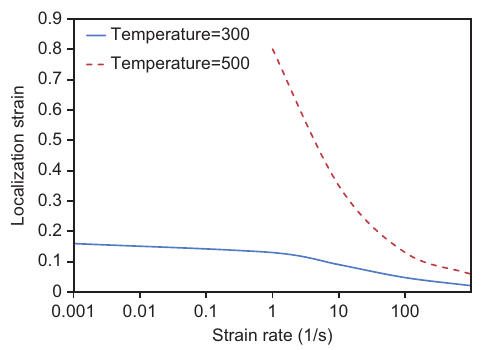
Figure 20 Occurrence of localization strain vs. strain rate for CR-1018 steel.